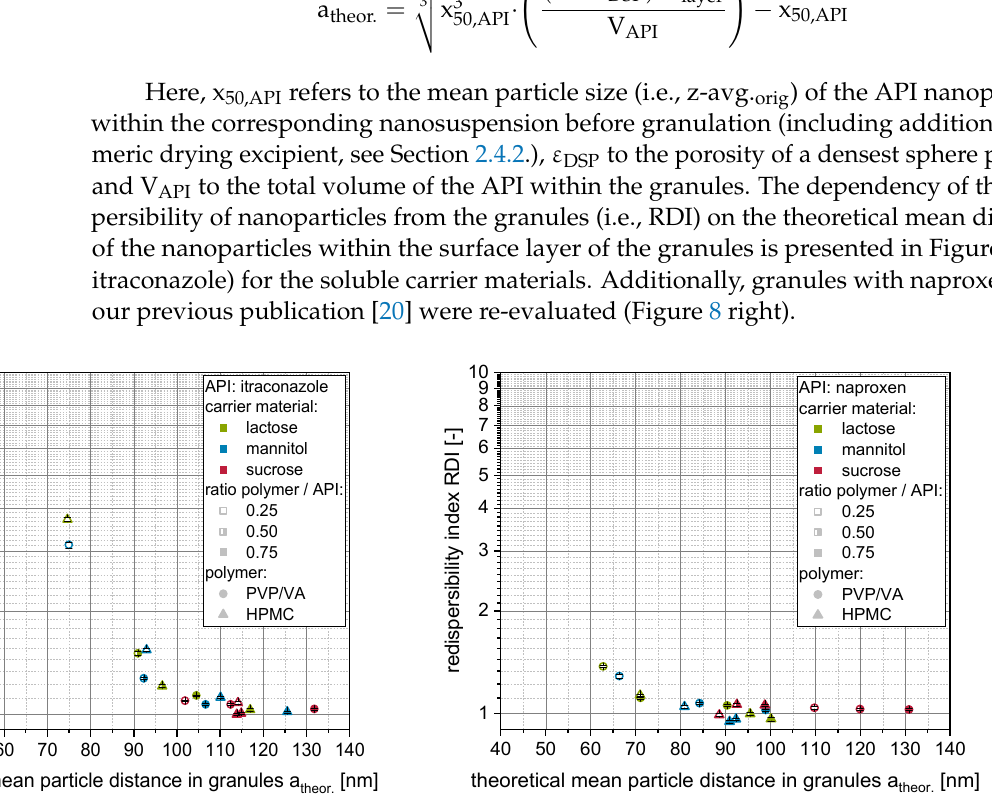
Figure 8. Correlation of the redispersibility index (RDI) with the theoretical mean nanoparticle distance for granules produced with itraconazole ( left ) or naproxen ( right ; data from [20]) nanosuspensions stabilized with different amounts of PVP/VA or HPMC and three different soluble carrier particles (lactose, mannitol or sucrose).